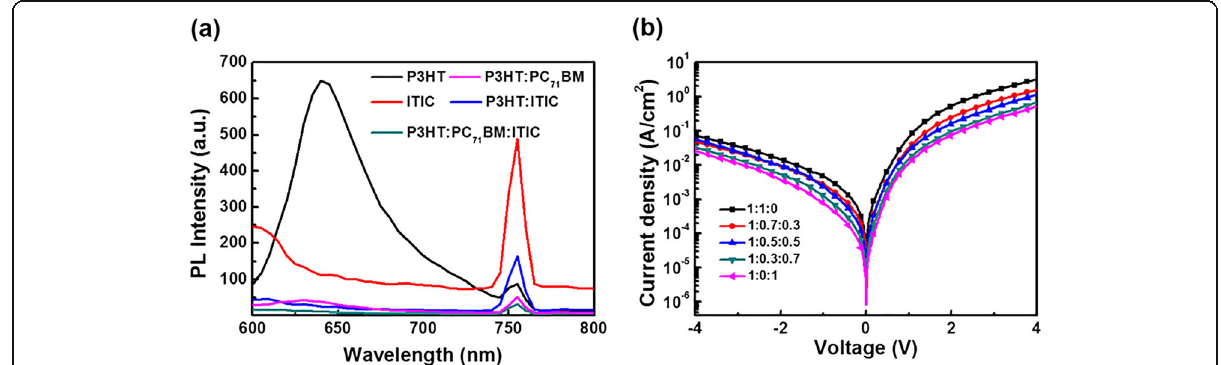
Fig. 3 a PL spectra of films under 500 nm light excitation. b J-V characteristics of electron-only